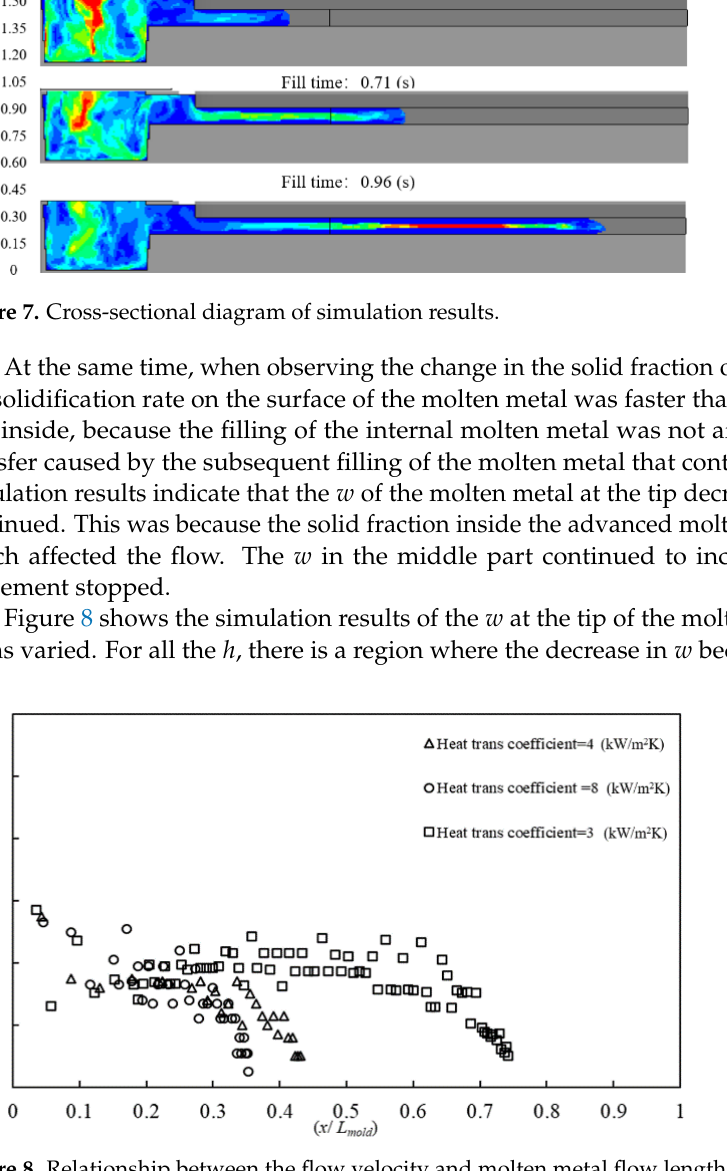
Figure 8. Relationship between the flow velocity and molten metal flow length of simulation results